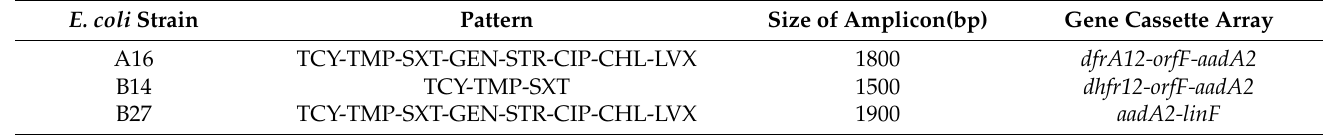
Table 3. Characteristics of class 1 integrons identified in E. coli from